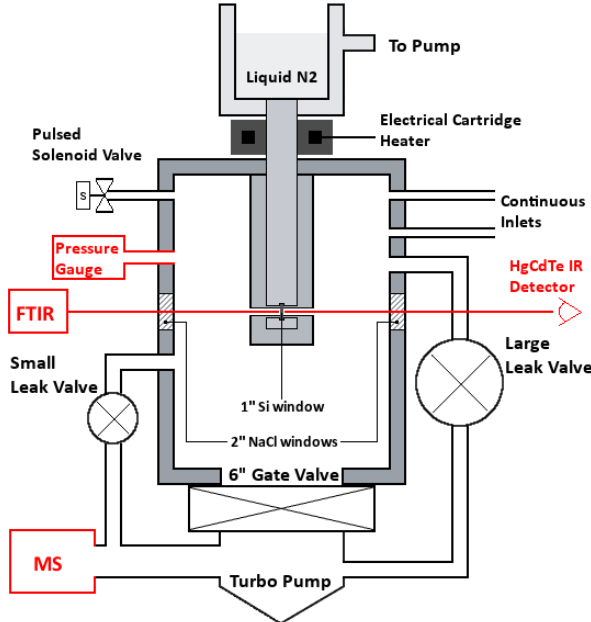
Figure 1: Schematic drawing of the reactor used in this work. The diagnostic tools are 1187 Figure 1. Schematic drawing of the reactor used in this work. The highlighted in red and important parameters are listed in Table 1. The ice film is 1188 diagnostic tools are highlighted in red, and important parameters are deposited on both sides of the 1” diameter Si window (black vertical symbol hanging 1189 listed in Table 1. The ice film is deposited on both sides of the 1 00 diameter Si window (black vertical symbol hanging from cryostat from cryostat inside reaction vessel). 1190 inside reaction